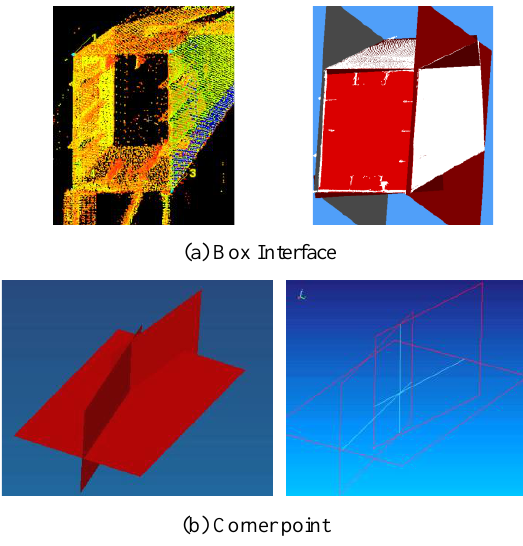
Figure4 feature extraction of box vetexs and corners